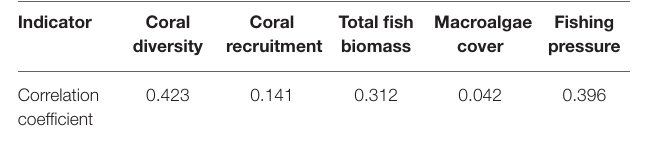
TABLE 3 | Summary of resilience scores generated from the localized and generalized assessments. Assessment